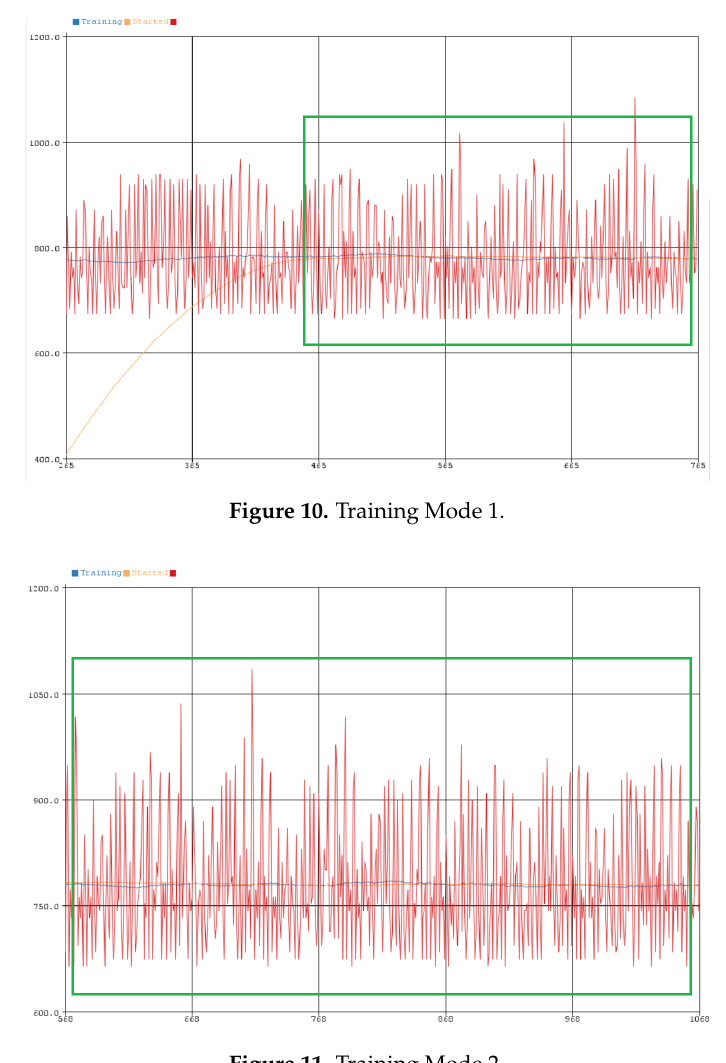
Figure 11. Training Mode